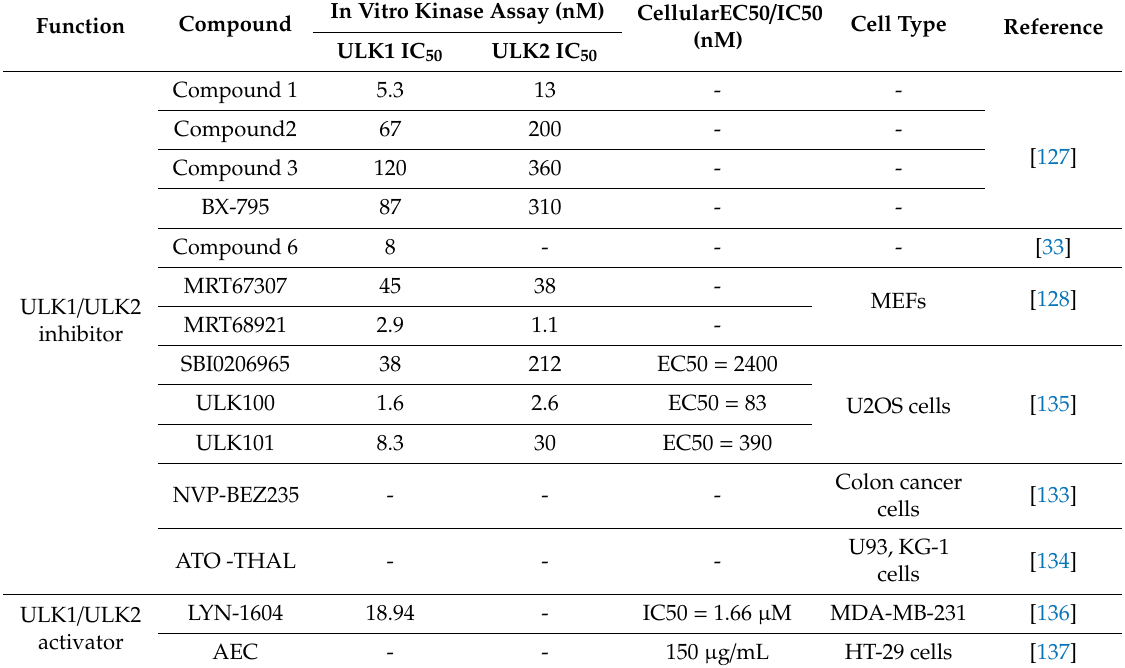
Table 3. Small-molecule compounds targeting ULK1 / ULK2-mediated autophagy in cancer.